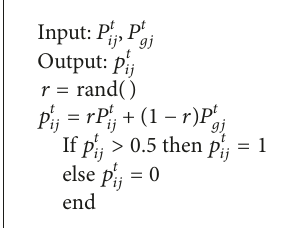
Algorithm 1: Get 𝑃 : 𝑝 𝑡 𝑖 discretization.